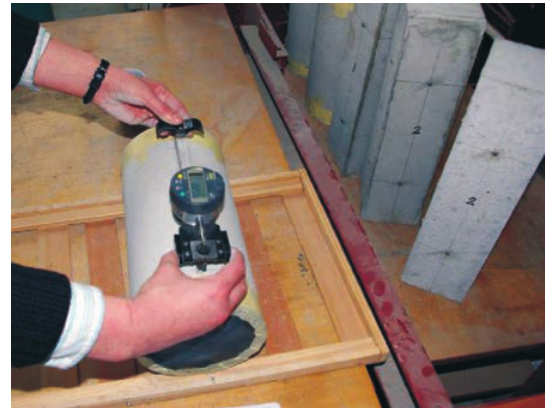
Fig. 3. Shrinkage measurement using the Demec strain gauge